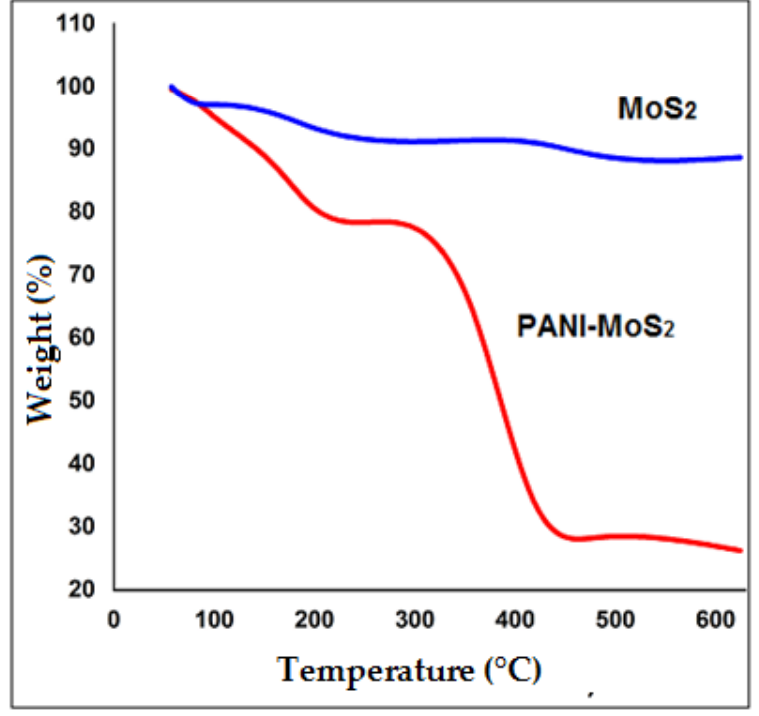
Figure 5. TGA profile of bare MoS 2 and PANI–MoS 2 .